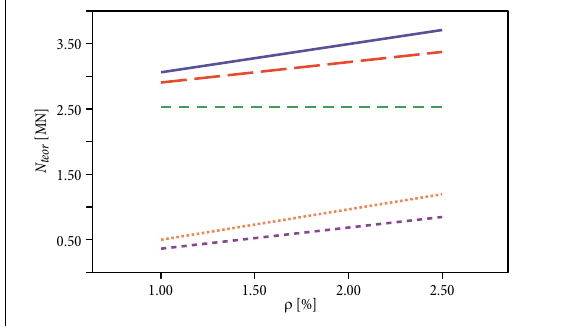
Fig. 6. The longitudinal reinforcement ratio ρ, the dependence on theoretical axial force N teor calculated by a different calculation algorithm by Eq. (7) [line – 1] and Eq. (6) [line – 2], where the carrying capacity of concrete N c [line – 3] and longitudinal reinforcement N f ( b ) [line – 4] and N f ( a ) [line – 5]